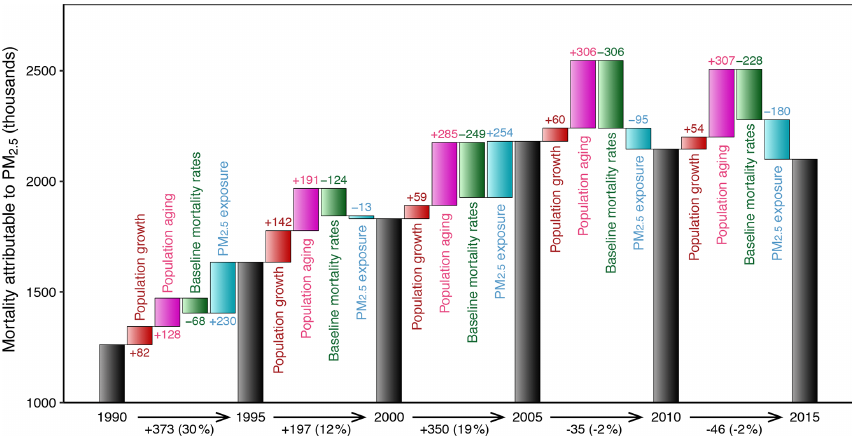
Figure 3. Contribution of factors to the changes in national PM 2 . 5 -related premature mortality estimated with GEMM NCD + LRI functions for each 5-year interval (in thousands). The length of each bar reflects the contribution of each